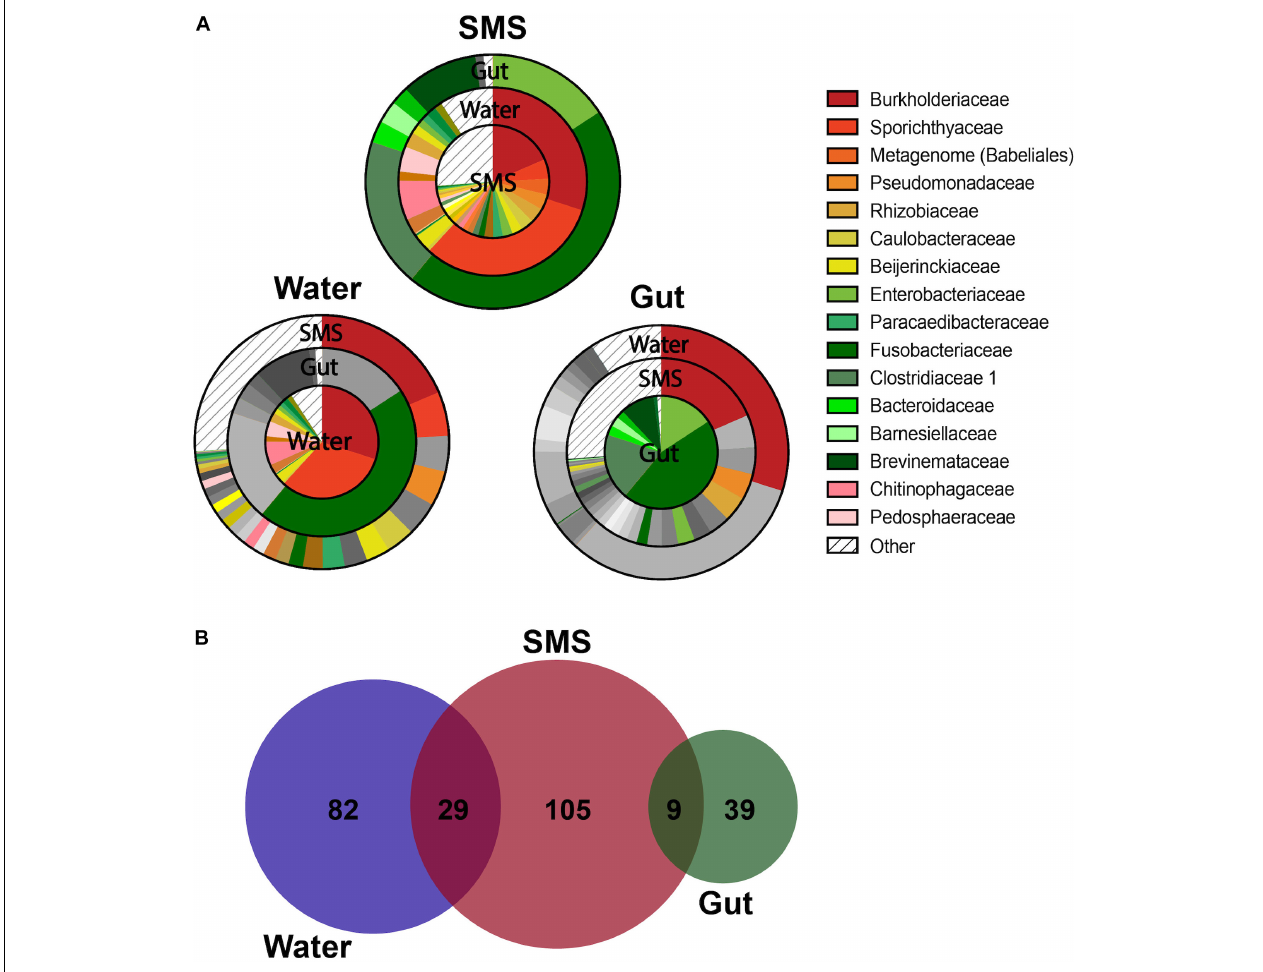
FIGURE 3 | Overlapping Taxonomy and Uniqueness Between SMS, Gut, and Water Communities. (A) Overlapping charts highlight the shared families between the communities, with the centers serving as the focus of the surrounding pie charts. For the surrounding communities, if a group is not present within the center community at a greater than 0.001% abundance, than it is grayed out. If the family is present, then it is colored at the appropriate proportion to indicate its relative abundance. Specific families were grouped into “Other” if they constituted less than 0.001% of their own microbiome. For differences in family abundances, refer to Figure 4A and Supplementary Figure S3 . (B) ASVs are depicted in a proportional Venn Diagram with a 0.01% abundance